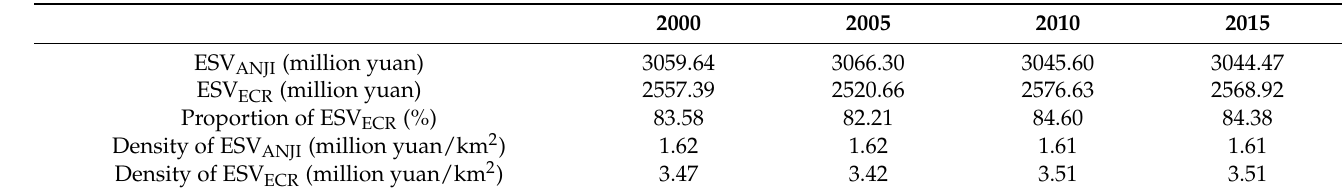
Table 2. Ecosystem services value (ESV) of the entire county and the Ecological Conservation Redline (ECR) areas.